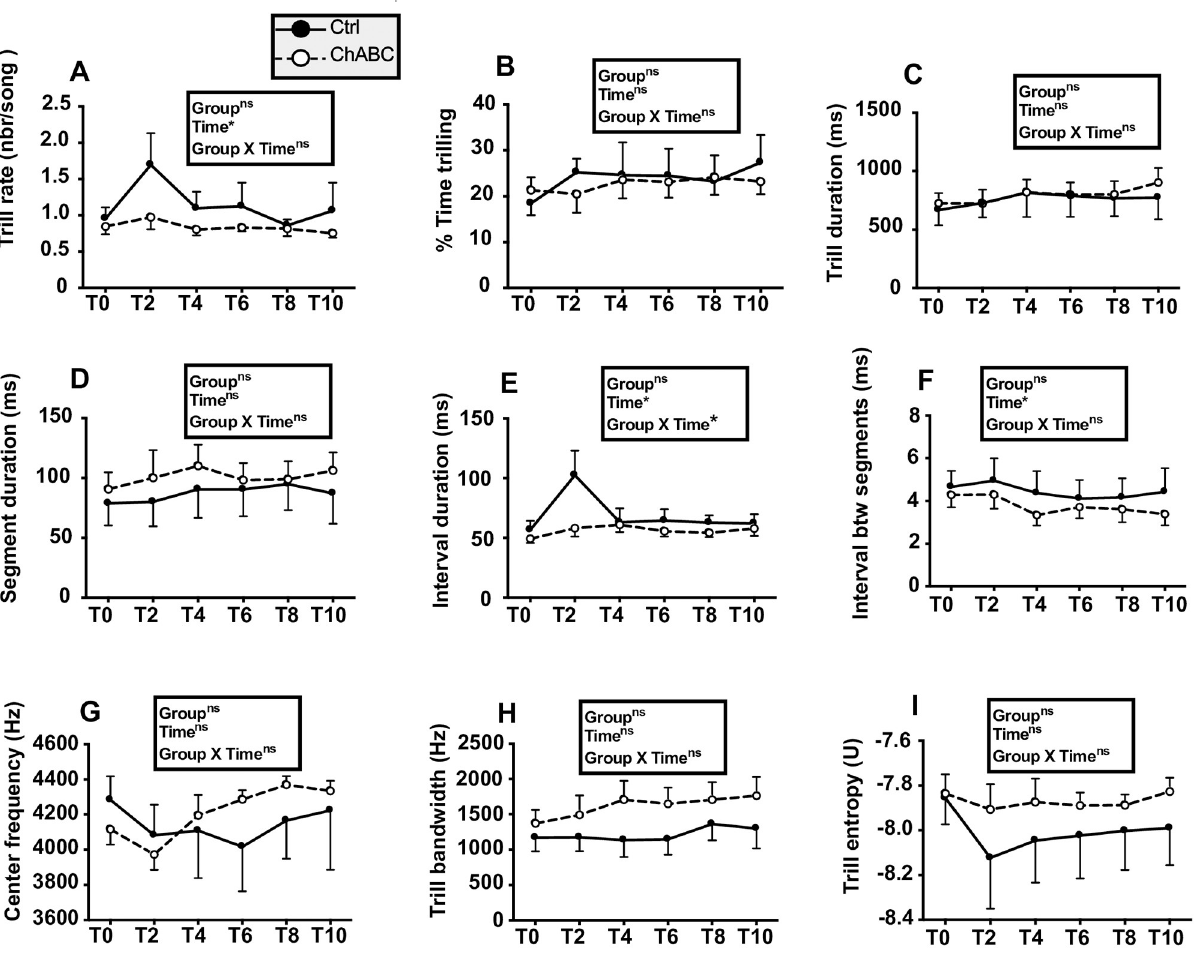
Fig 12. Trill rate and trill features before (T0) and 2, 4, 6, 8 or 10 weeks after (tests T2 to T10) bilateral treatment of HVC with ChABC or the saline control. Data were analyzed by two-way ANOVA with groups as independent factor and time as a repeated factor and results are summarized in the insert for each panel. N = 7 Ctrl and 8 ChABC